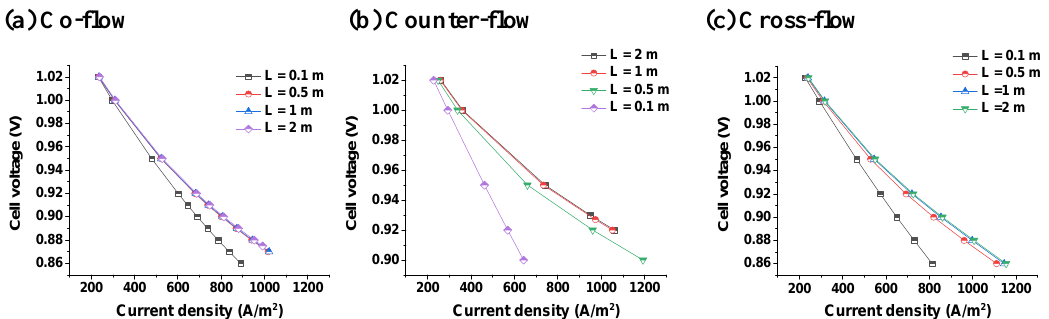
Figure 12. I–V curves relative to the length for ( a ) co ‐ flow, ( b ) cross ‐ flow, and ( c ) counter ‐ flow cells.